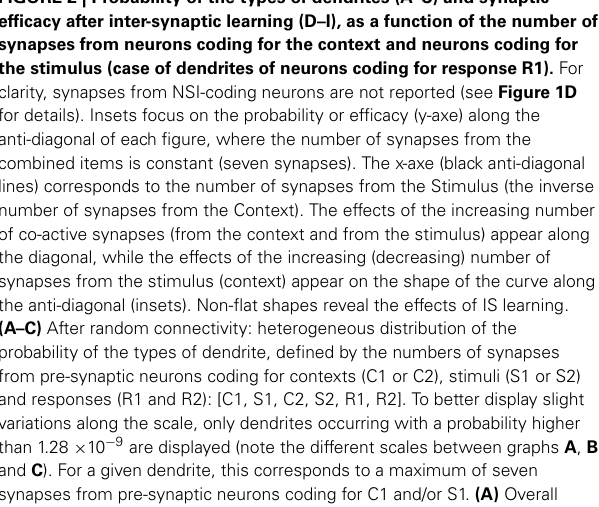
probability (over all synapses from C2, S2, R1, R2, and NSI-coding neurons) of the types of dendrites, as a function of the number of synapses from neurons coding for C1 and S1 (mean = 0.02; min = 2.80 × 10 − 9 ; max = 0.11). (B,C) Two types of relevant dendrites (see text). (B) Overall probability of [C1 = 4, S1 = 4, C2, S2, R1, R2] dendrites (averaged over all types) with any number of synapses from C2, S2, R1, and R, as a function of the number of synapses from neurons coding for C2 and S2 (mean = 3.52 × 10 − 5 ; min = 7.50 × 10 − 10 ; max = 2.35 × 10 − 4 ). (C) Same as (B) but regarding [C1 = 2, S1 = 2, C2, S2, R1, R2] dendrites (mean = 0.001; min = 9.10 × 10 − 10 ; max = 8.65 × 10 − 3 ). ( D-F ) Amplification of potentiation and depression through IS learning of the combination C1S1R1: Sum of the efficacy of two synapses J R 1 − S + J R 1 − C from pre-synaptic neurons coding for the stimulus and the context for the different types of dendrites defined in (A–C) . Amplification of potentiation and depression with the number of synapses in the dendrites indicates that IS learning of the C1S1R1 combination generates different efficacy values in different dendrite. (D) Amplification of the potentiation along the diagonal when the number of synapses increases (mean = 0.83, min = 0 and max = 1.22, compare to I ). Synaptic efficacy is weak when one type of synapses (from C1 or S1) is absent along the anti-diagonal (inset). (E,F) Two types of dendrites having [4C1, 4S1] or [2C1, 2S1] synapses further show the efficacy of two synapses J R 1 − S 1 + J R 1 − C 1 as a function of